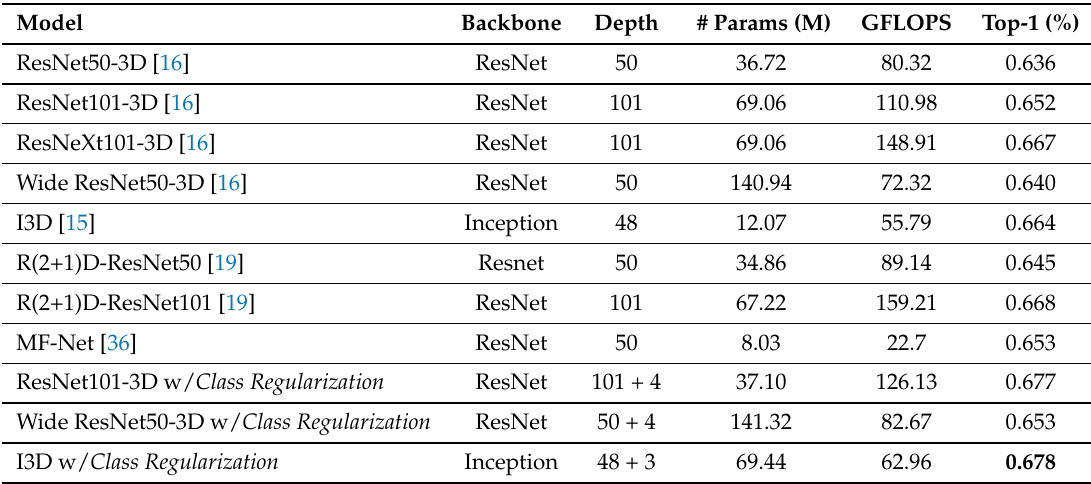
Table 2. Accuracy rates of different spatiotemporal convolutional architectures on the Kinetics-400 dataset. Model